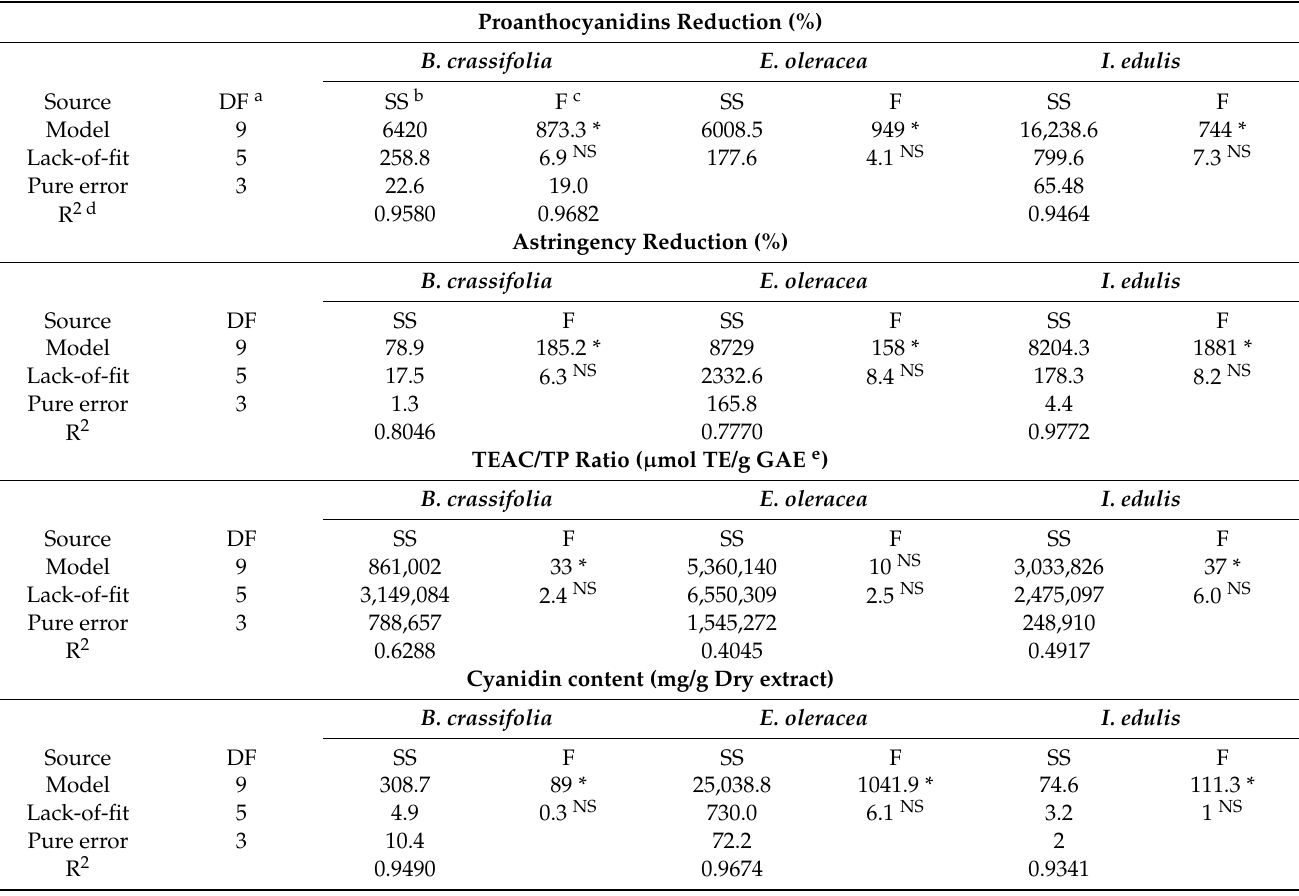
Table 3. Analysis of variance and coefficients of determination obtained from experimental data for the response